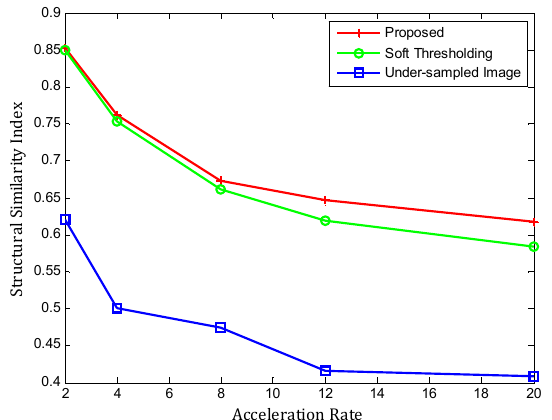
Figure 13. This figure depicts the efficiency of proposed algorithm by means of SSIM index. As acceleration rate increases, the SSIM of proposed algorithm degrades slowly while comparing it with IST algorithm.